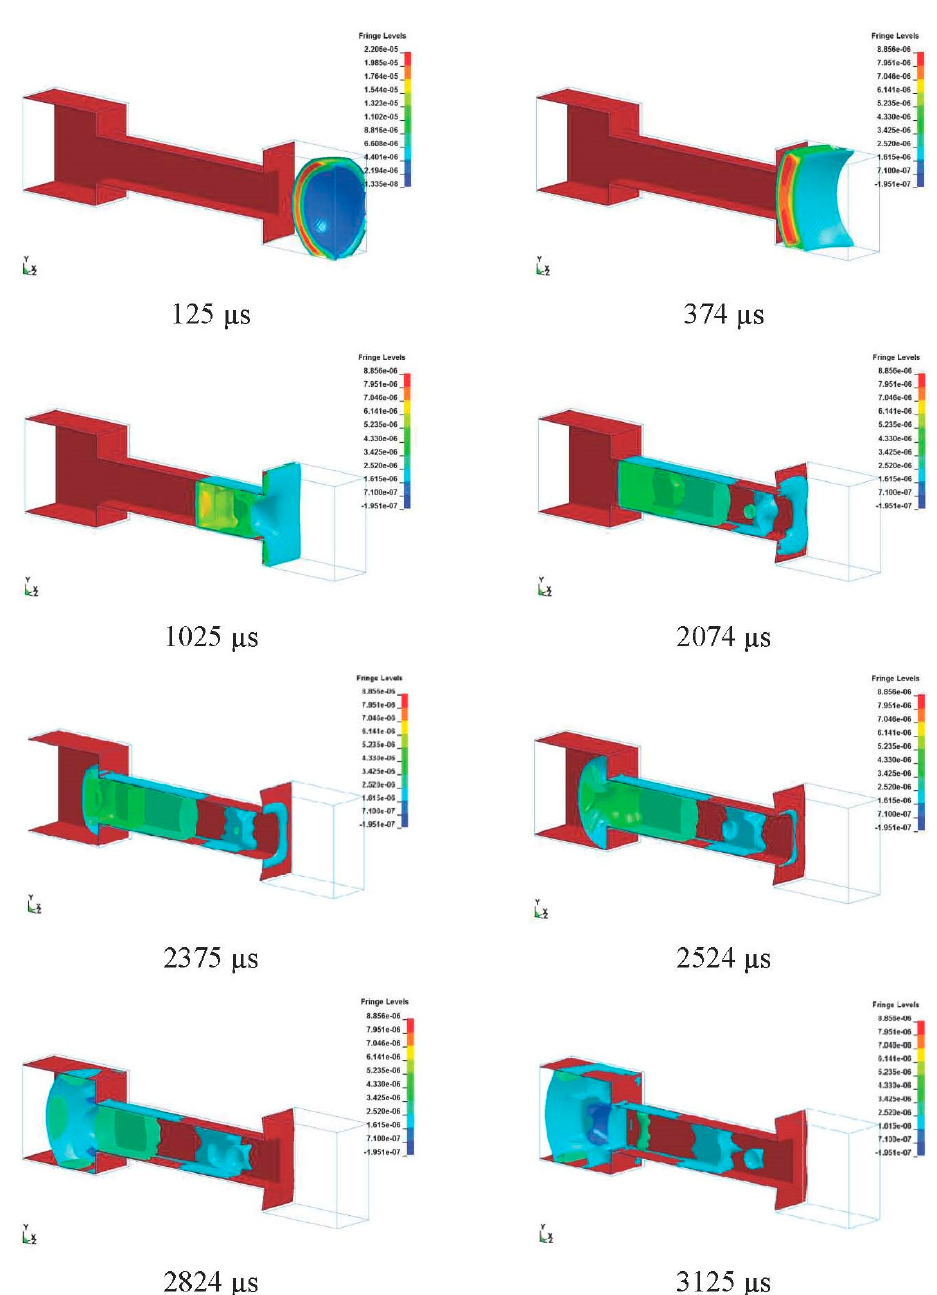
Figure 6. Blast transfer in numerical simulation of linear tunnel with expansion chamber explosion (100 g C-4). When the quantity of the explosive was ≤ 350 g, the one-pressure relief orifice plate design mode can reduce the blast transfer rate to 0.49, meaning the blast was transferred from P3 to P4, and the blast could be attenuated by 51% by reducing the tunnel section.